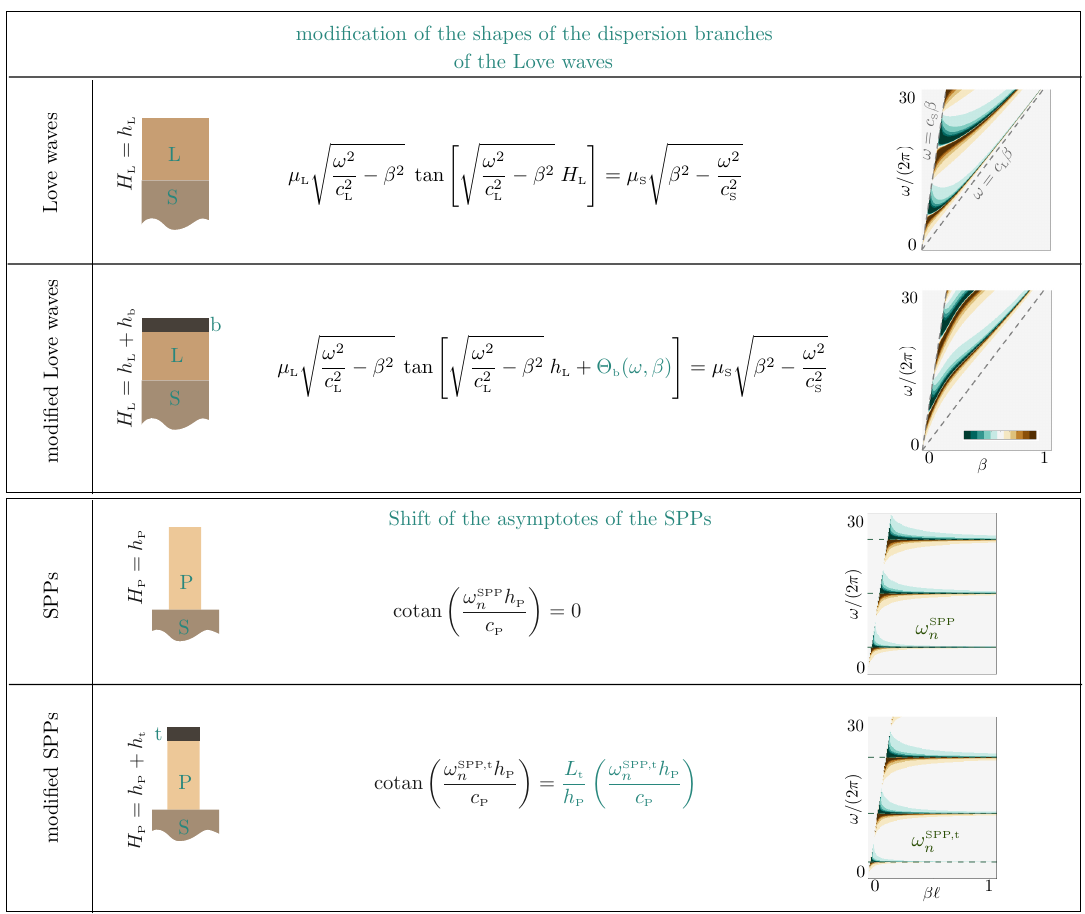
Figure 5. Reference solutions: Dispersion relations of Love waves and modified Love waves (with a bottom layer of thickness h ). In the presence of a thin layer b atop the guiding layer, the dispersion b relation is modified ( Θ in (16)) resulting in different shapes of the Love dispersion branches. SPP, b Spoof Plasmon